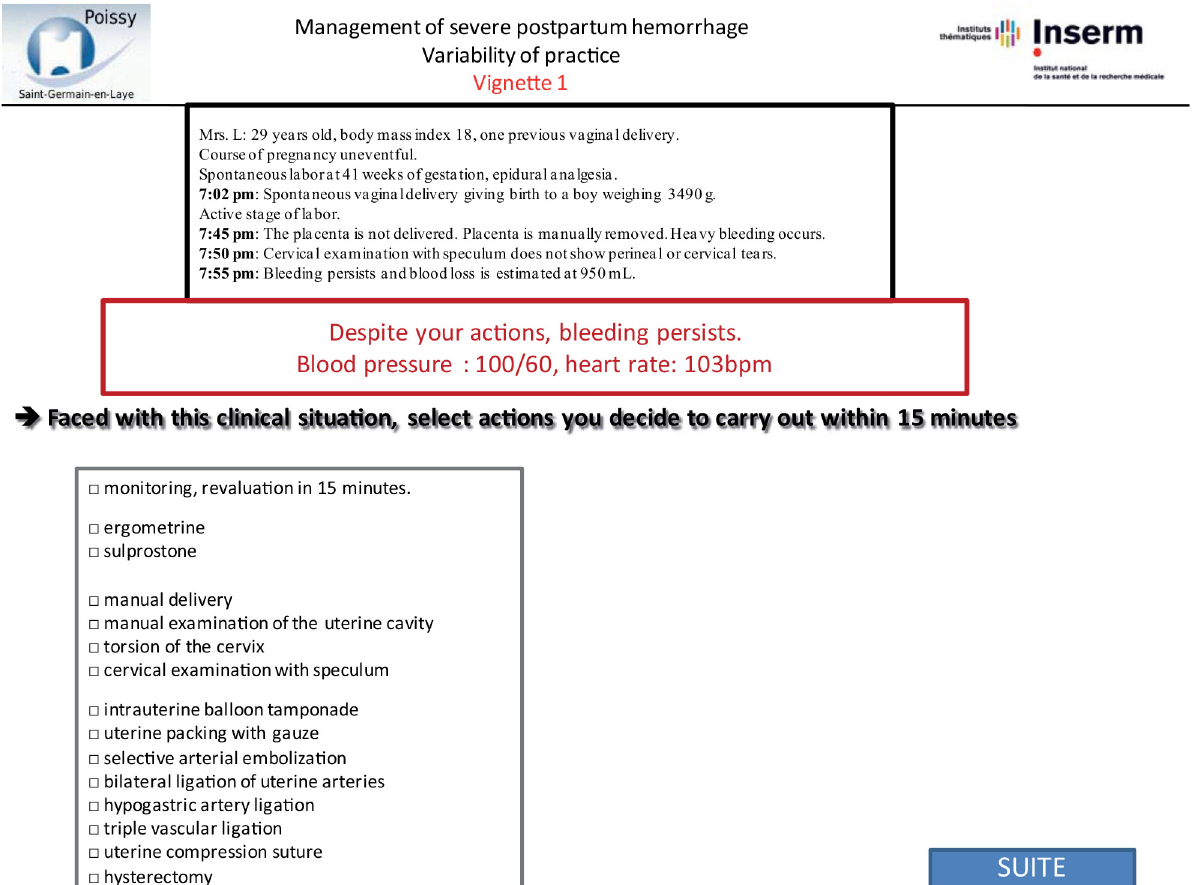
Fig 2. Step 2 of sample vignette. This figure corresponds to screenshot of the website: second step of the same vignette with the same closed-ended